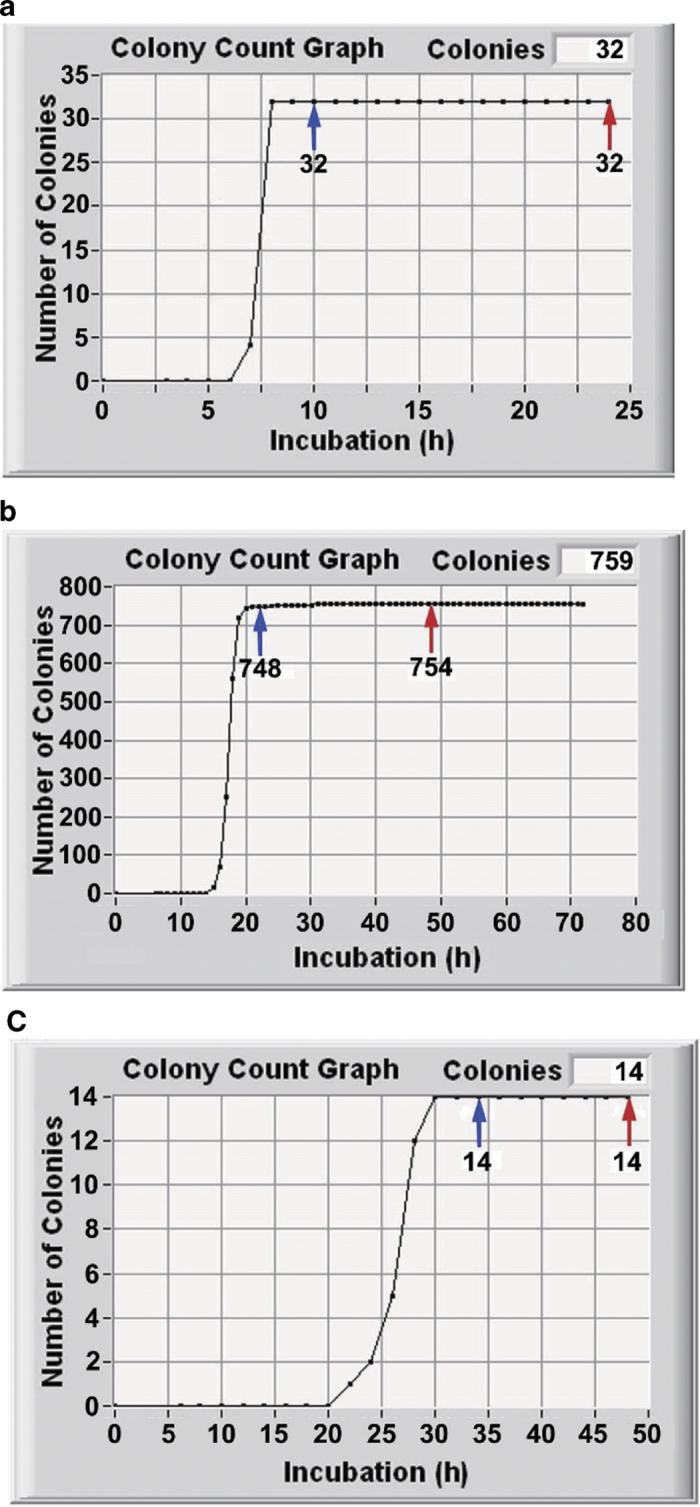
TSIA data of pure culture samples. Time courses of Ni of (a) E. coli, (b) C. albicans, (c) A. braciliensis. Blue arrows: Nstdy, red arrows: Nconf.